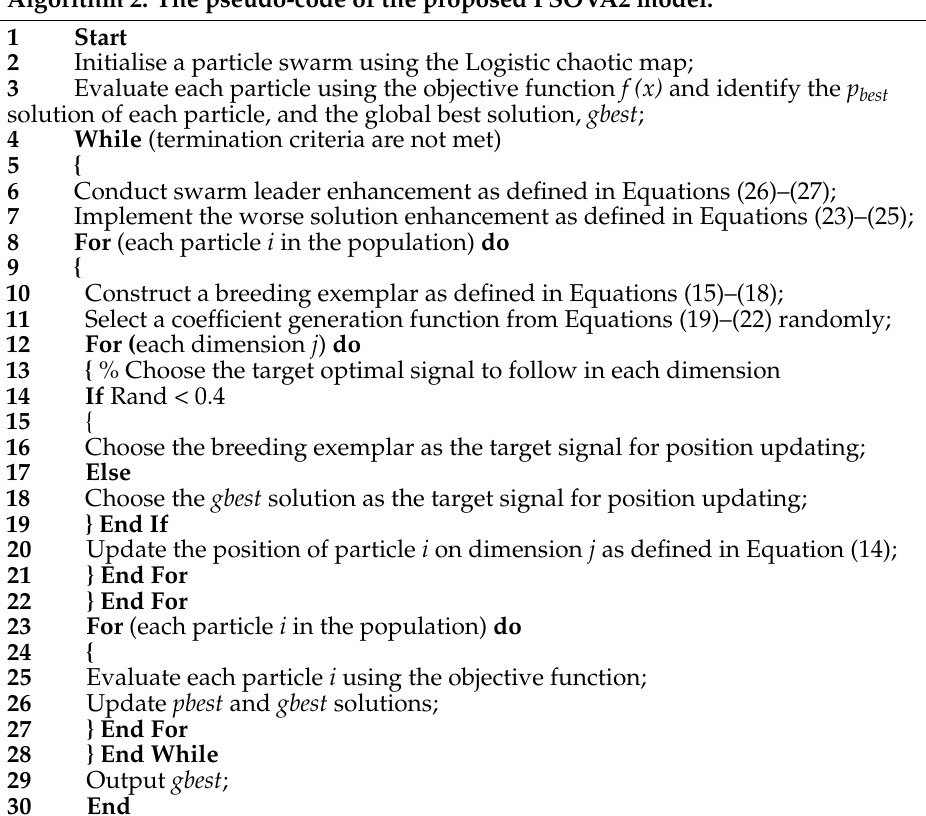
Algorithm 2. The pseudo-code of the proposed PSOVA2